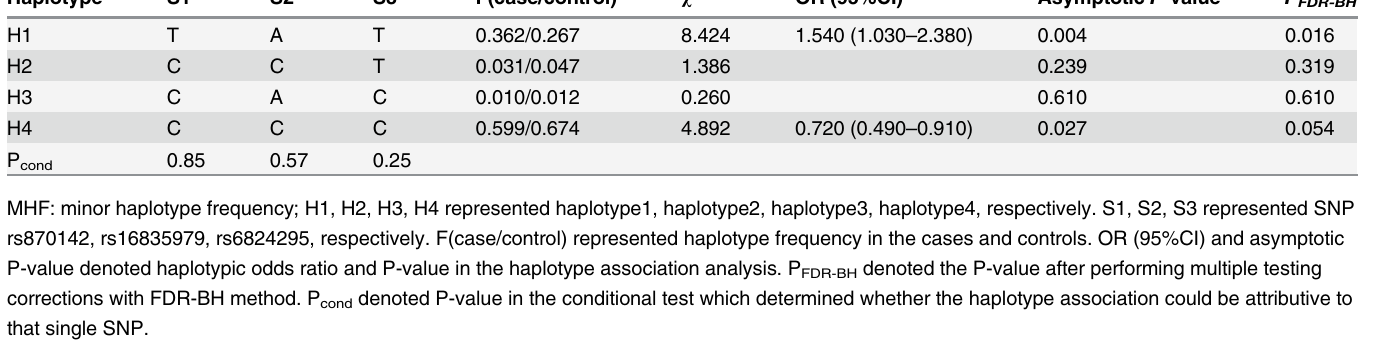
Table 3. Haplotype main effect and conditional haplotype-based analysis tests (MHF > 0.01).